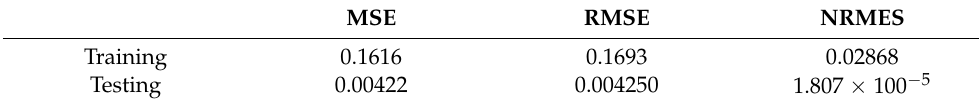
Figure 7. Future prices of the AMP cryptocurrency. Table 5. Results of the LSTM model in predicting the prices of the Ethereum